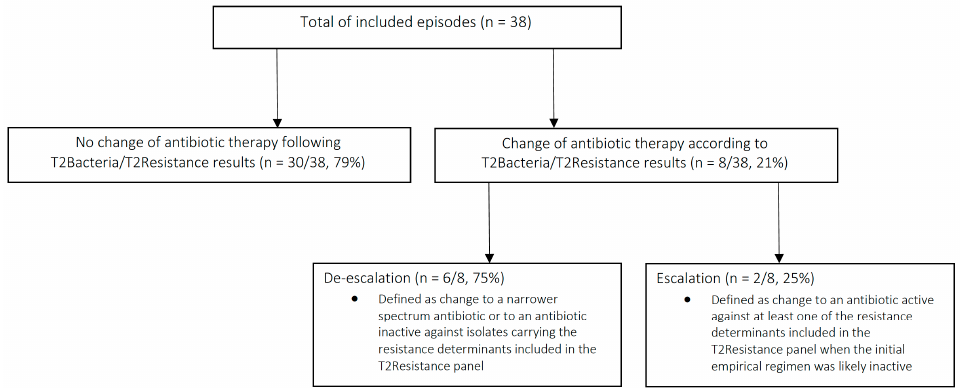
Figure 1. Changes in antibiotic therapy according to T2Bacteria/T2Resistance results before availability of blood cultures results.